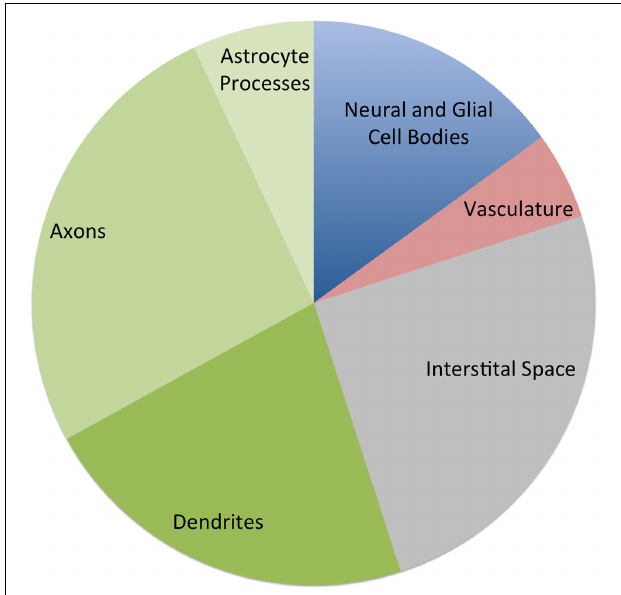
FIGURE 2 |Approximate percentage of the components of cerebral gray matter by volume, based on estimates from several histological studies. The three green wedges are all components of the neuropil (Cherniak, 1990; Syková, 1997; Braitenberg and Schüz, 1998; Chklovskii et al., 2002; Kleim et al.,